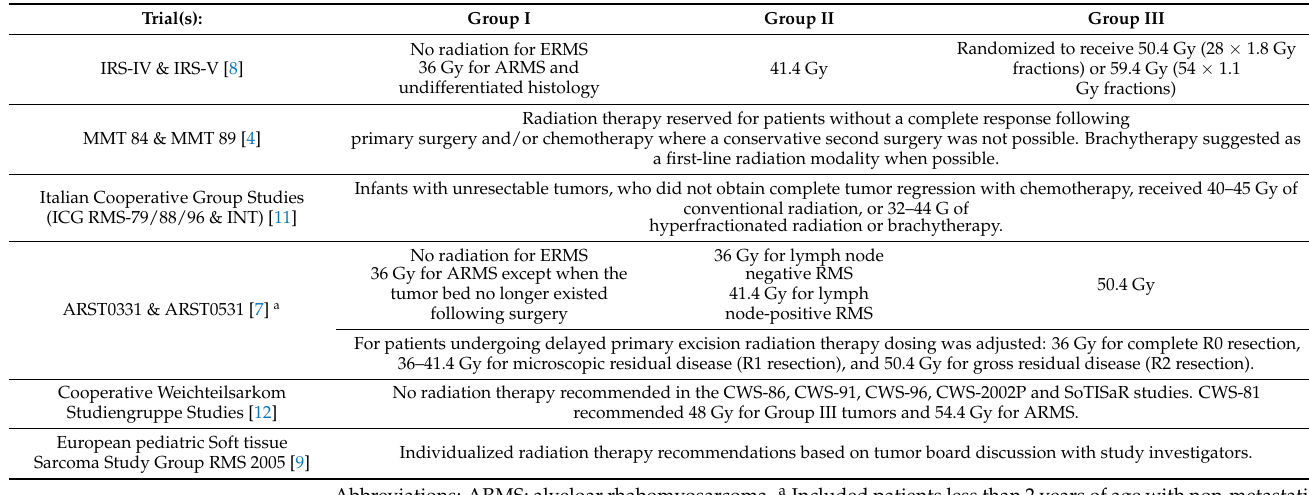
Table 3. Radiation therapy recommendations for local control for infants under one year of age with rhabdomyosarcoma in clinical